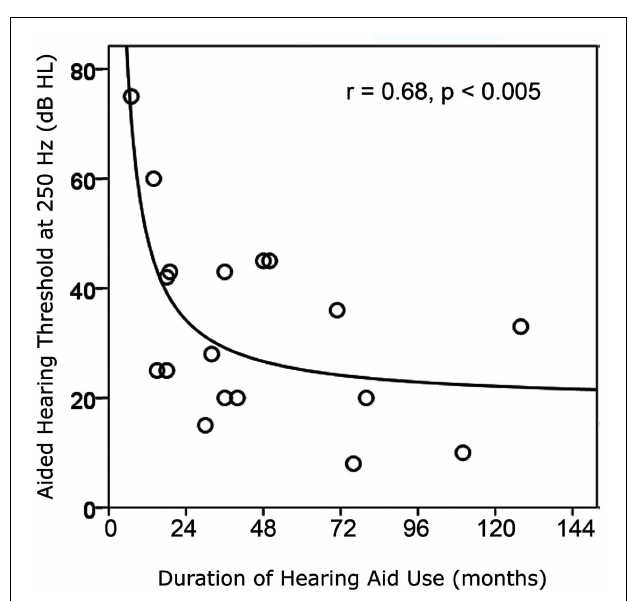
FIGURE 2 | Duration of hearing aid use prior to cochlear implantation increased as hearing at 250 Hz with the use of hearing aids improved (i.e., lower